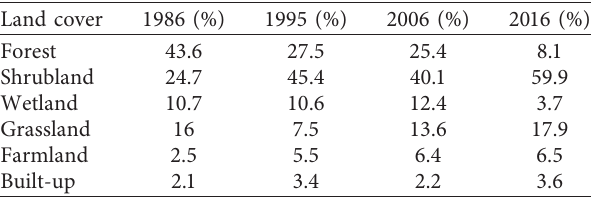
Table 4: Percent land cover changes in West Bugwe Central Forest Reserve for the period